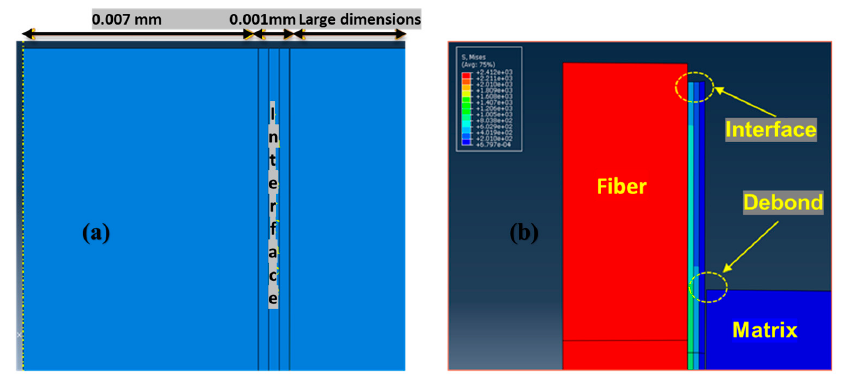
Figure 8. Shear stress distribution across the constituents—( a ) dimension of the unit cell model, ( b ) debond stage. The stress contour plot is also seen here.